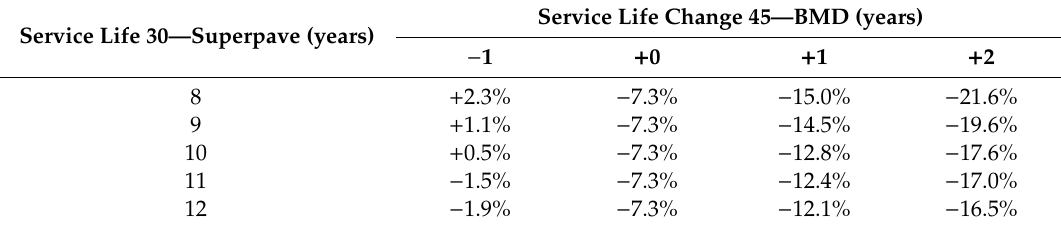
Table 5. Cost increase / reduction in 45-BMD with respect to 30-Superpave